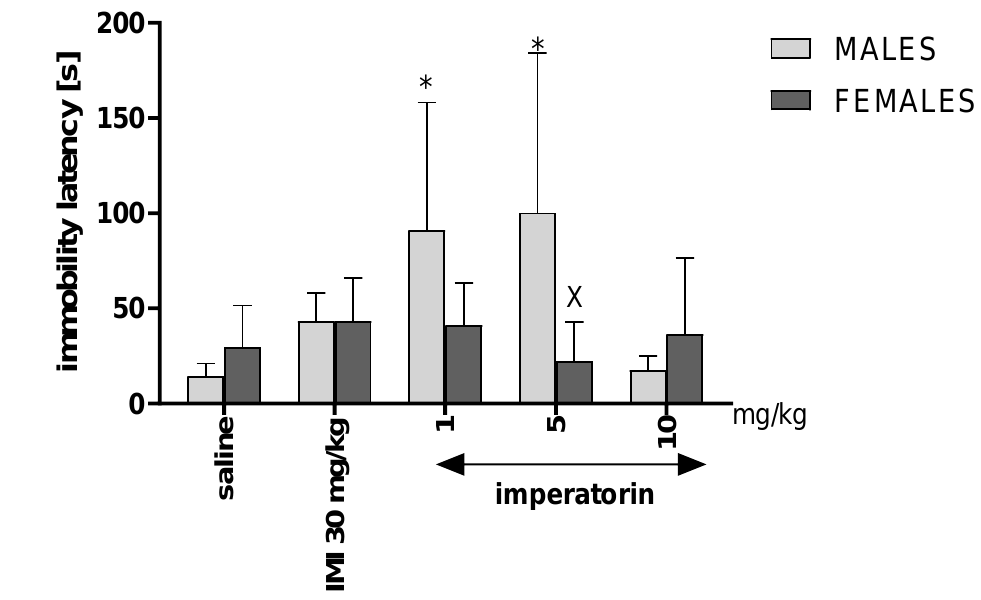
Figure 2. The immobility latency [s] as measured from the beginning of the FST to the first immobility event. Imipramine (IMI, 30 mg/kg, i.p .), imperatorin (1, 5, and 10 mg/kg , i.p. ), and saline were administered 30 min before testing; n = 8–10; mean ± SD; * p < 0.05 vs. saline-treated male control group; X p < 0.05 vs. imperatorin-treated male group; Bonferroni’s test. Two-way ANOVA analysis revealed a statistically significant sex difference (F (1, 86) = 11.85, p = 0.0009), and drug treatment effect (F (4, 86) = 7.625, p < 0.0001), but no significant sex * drug interaction (F (4, 86) = 1.531), p = 0.2016) on 5-HT levels in the prefrontal cortex (Figure 3B). Post hoc pairwise comparisons with Bonferroni’s correc- tion showed increased level of 5-HT in females after imperatorin injection (1 mg/kg: ** p < 0.01 vs. saline). Imperatorin (1 mg/kg: XX p < 0.01) caused an increase in 5-HT levels in females vs., males. Additionally, imipramine (for 30 mg/kg: ** p < 0.01) in females and males (30 mg/kg; * p < 0.05) caused increase in 5-HT level vs. female and male control groups, respectively (Figure